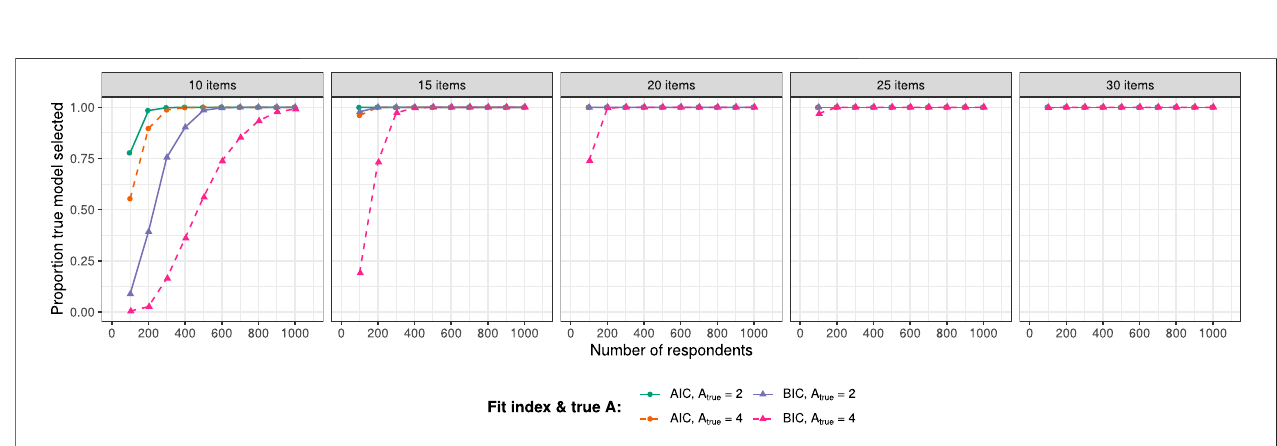
FIGURE5| ProportionofreplicationswhereAICandBICpreferredthetruemodeloverthetoocoarse-grained model.Resultsaredisplayedfortheconditionswith A true = 2 and A est = 1, 2, and with A true = 4 and A est = 2, 4.